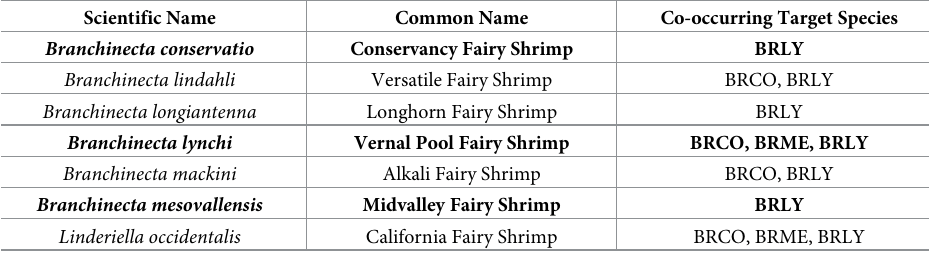
Table 3. A list of off-target species used to test each assay.